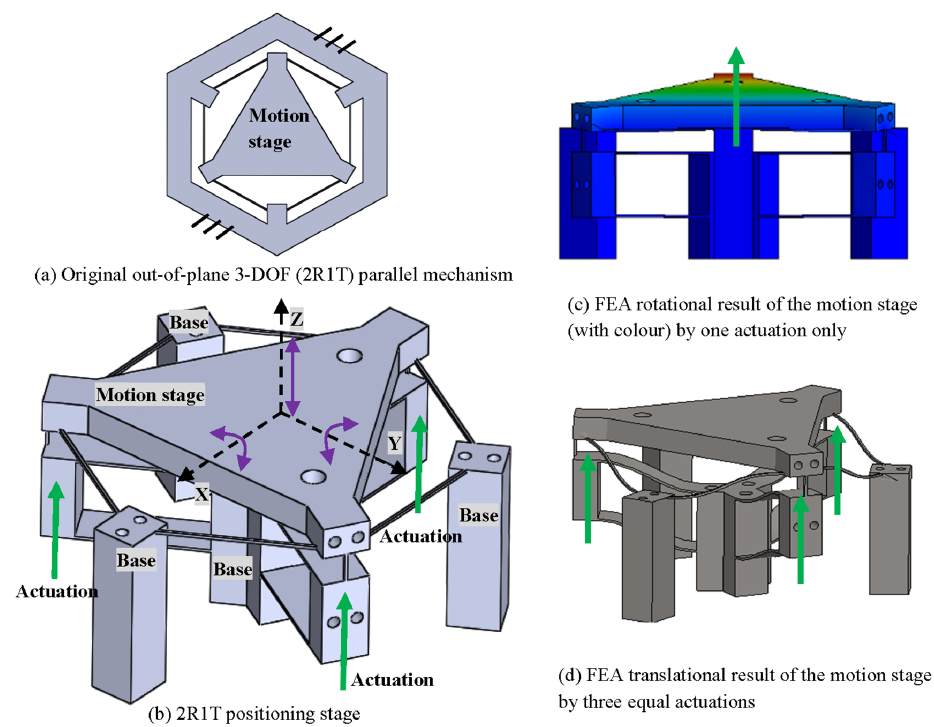
Figure 2. Design of an out-of-plane 3-DOF 2R1T CPM with actuation